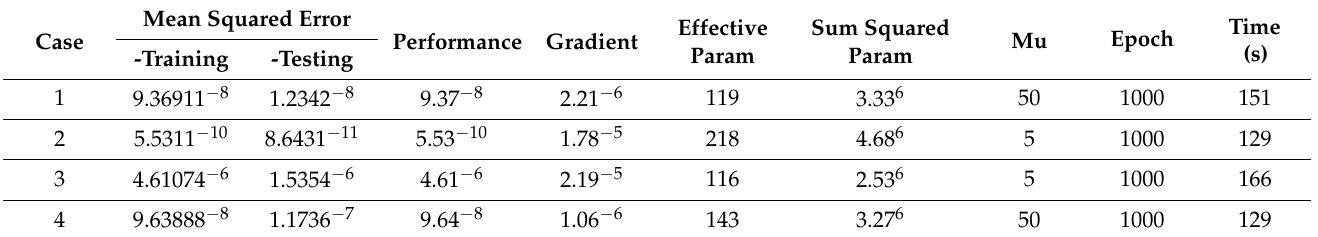
Table 4. Performance analysis of BRM-NNs for the proposed